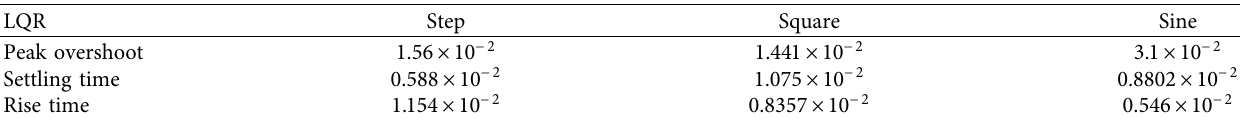
Table 3: LQR output